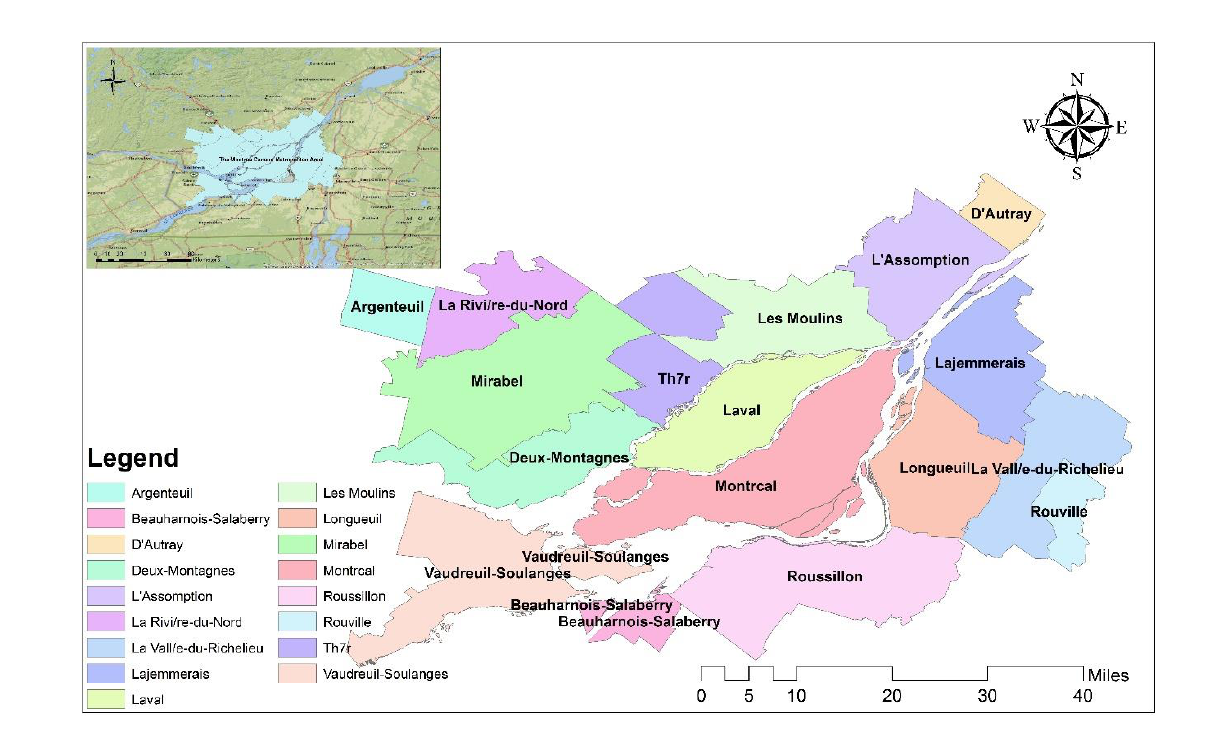
Fig. 1 . Study area – The Montréal Census Metropolitan Area